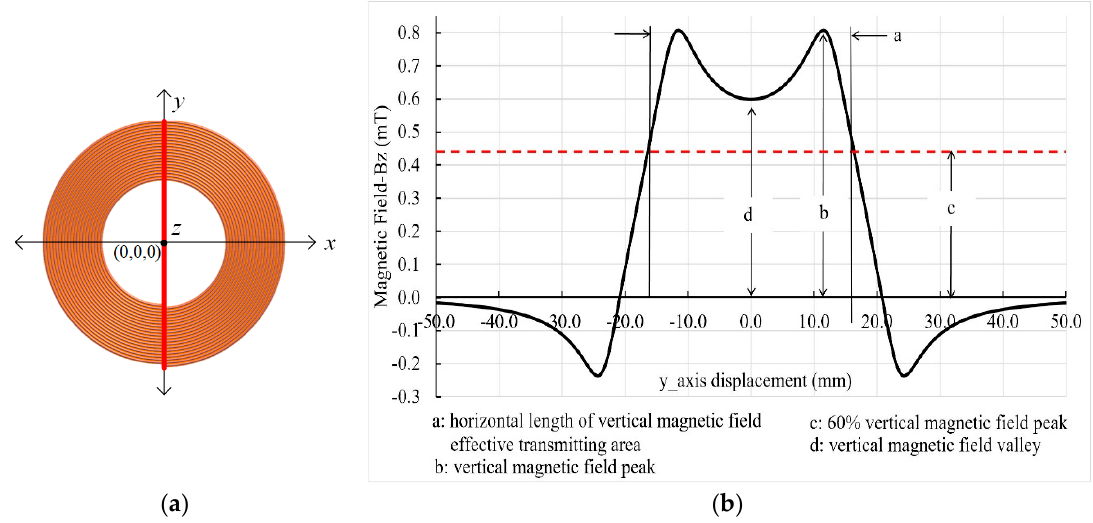
Figure 6. ( a ) Evaluation path along the y-axis, ( b ) vertical magnetic field distribution along the